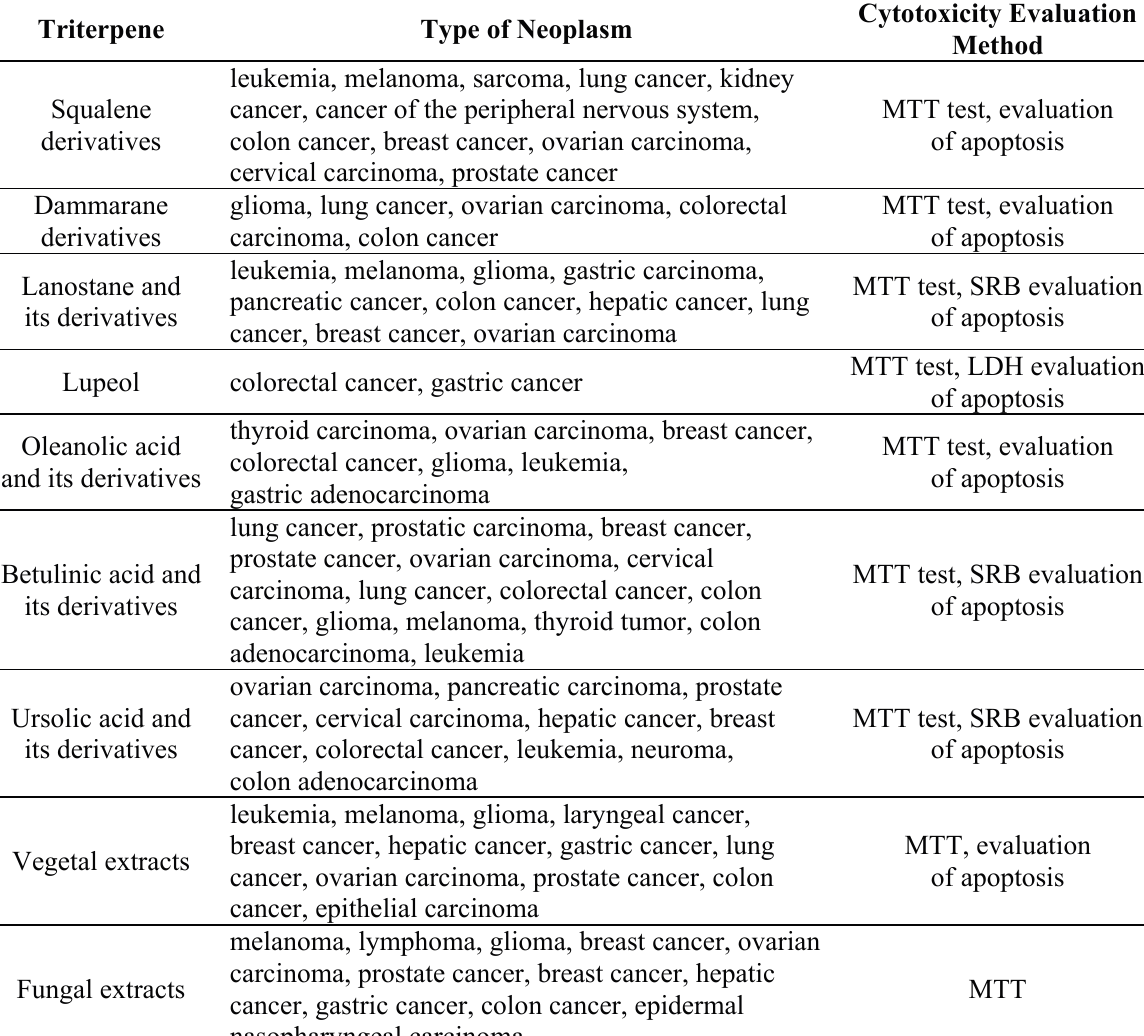
Table 1. Examples of neoplastic cell lines sensitive to cytotoxic properties of triterpenes.